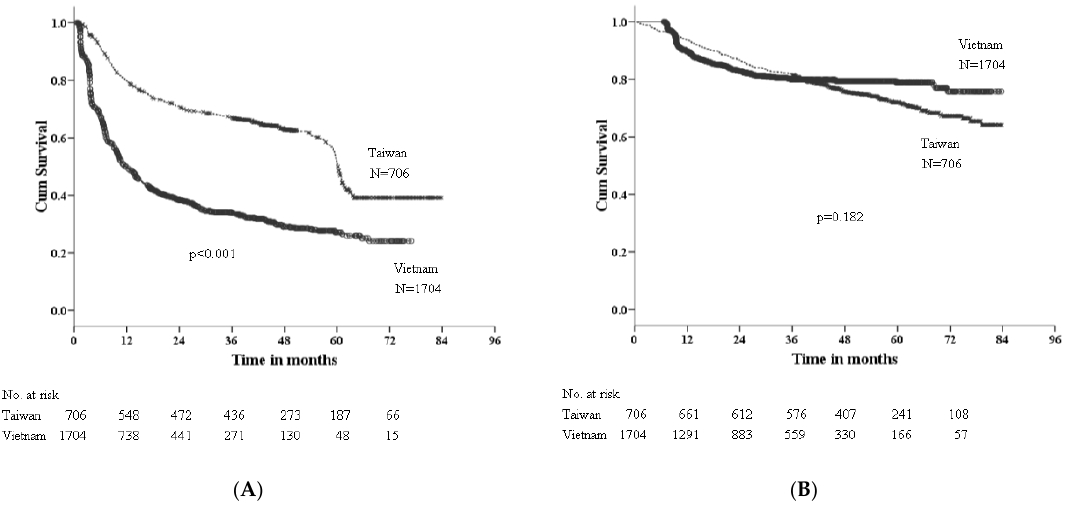
Figure 1. ( A ). Recurrence-free survival after resection of HCC, stratified by site of treatment. ( B ). Overall survival after resection of HCC, stratified by site of treatment.